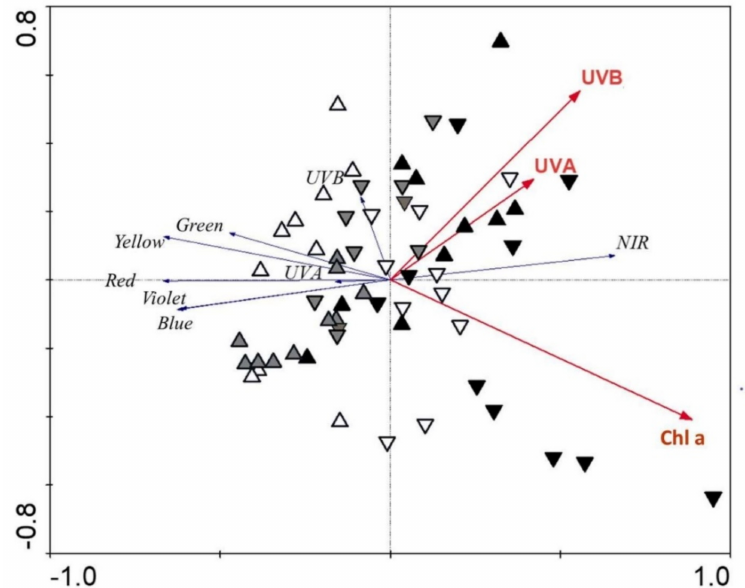
Figure 4. Redundancy analysis plot showing the strength of the associations between the sepal traits and different regions of the transmittance spectra for H. niger (up-triangles) and H. odorus (down- triangles). White triangles—developing phase; grey triangles—flowering phase; black triangles— fruiting phase. Only significant sepal parameters are shown. Chl a—chlorophyll a ; UVA—UV-A- absorbing substances; UVB—UV-B-absorbing